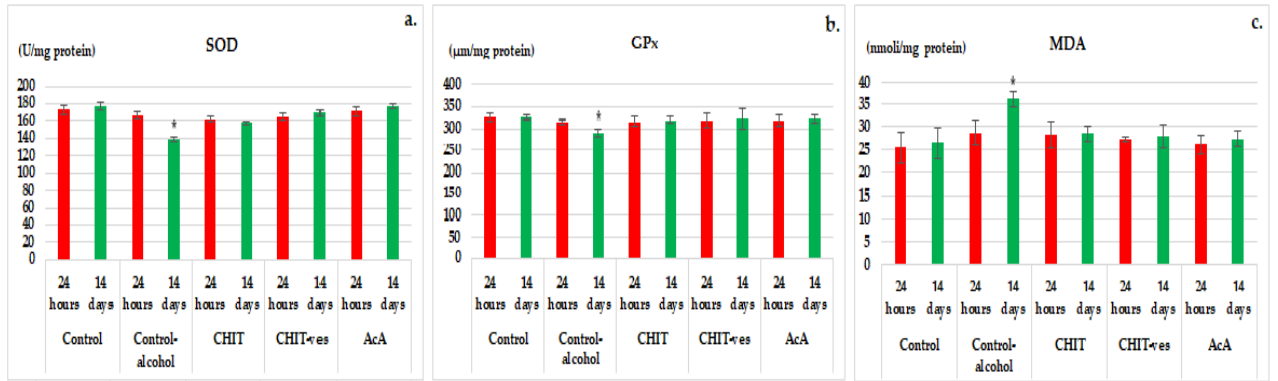
Figure 8. The effects of chitosan, chitosan vesicles and ascorbic acid on SOD ( a ), GPX ( b ) and MDA ( c ) activity in mice (mean ± S.D. of the average values—groups of 6 animals * p <0.05).